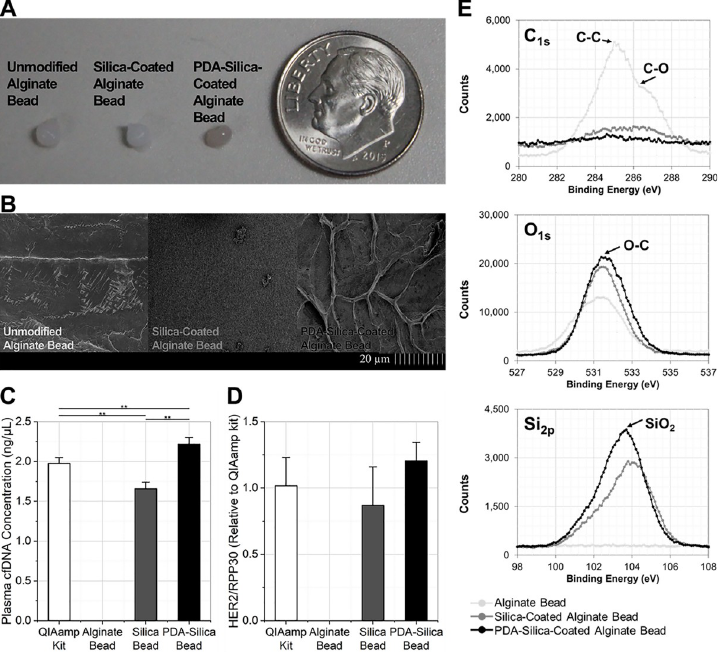
microscopy (SEM) after coating PDA-silica hybrids on the bead surface. (c) cfDNA adsorption from each assay compared using cell culture supernatants obtained from a gastric cancer cell line, AGS. PDA-silica hybrids showed enhanced cfDNA adsorption by 1.12-fold (p = 0.019) and 1.34-fold (p = 0.001) compared to the QIAamp DNA mini kit and silica-coated alginate beads, respectively. (d) The relative amount of cfHER2 DNA quantified from each